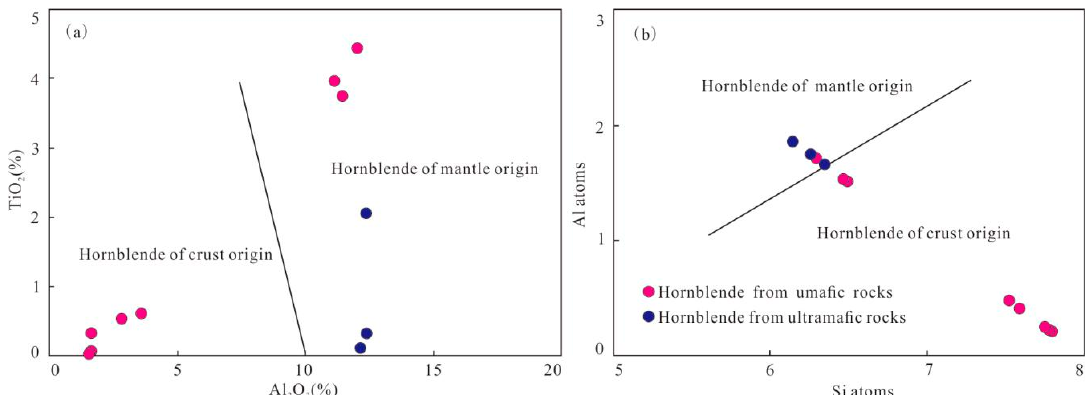
Figure 9. Al 2 O 3 -TiO 2 ( a ) and Si-Al atoms ( b ) diagrams of calcium hornblendes showing the mantle and crust origins, respectively, in the Niubiziliang mafic-ultramafic complex (modified after Jiang